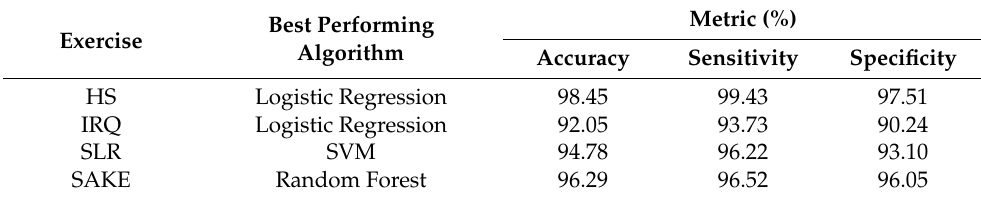
Table 3. Lab-based results following leave-one-subject-out cross-validation.